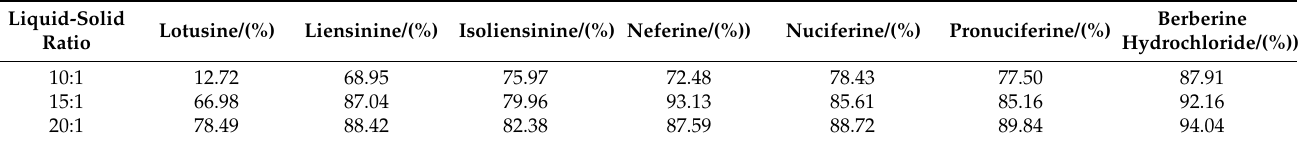
Table 1. Effect of liquid–solid ratio on the extraction yields of seven kinds of